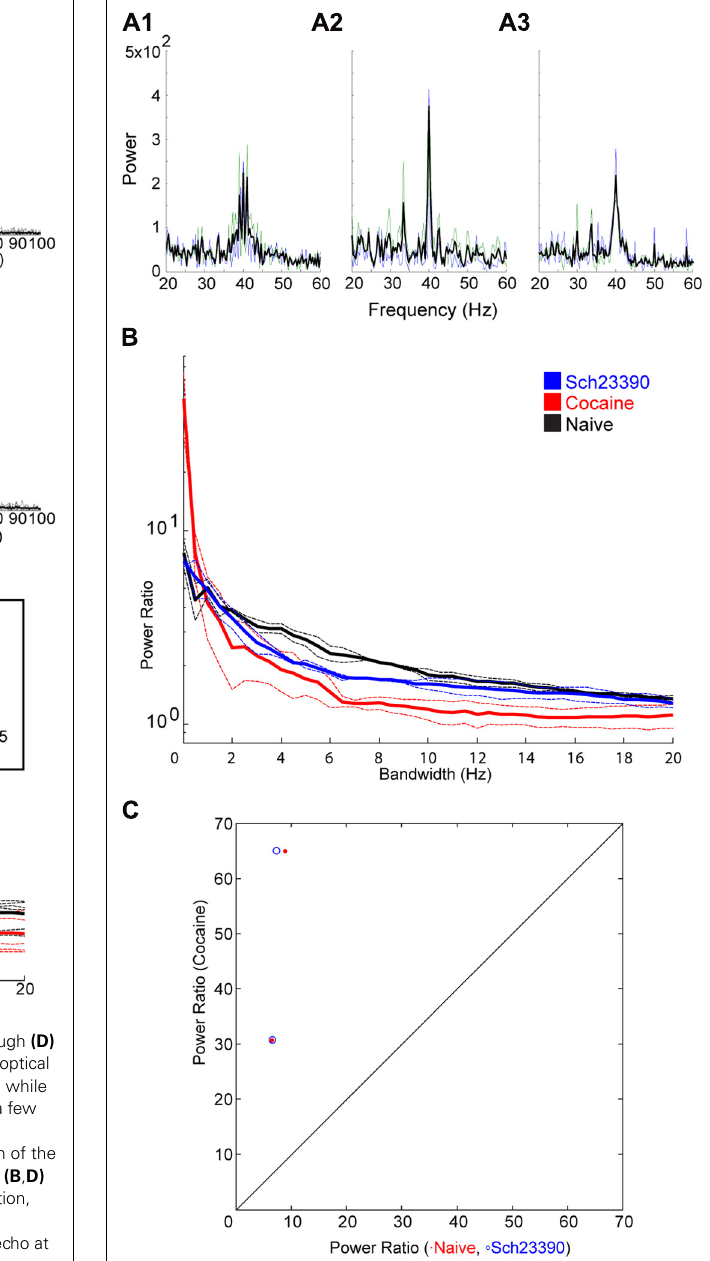
FIGURE 5 | Effect of the D1 antagonist SCH23390 on the cocaine induced change to the induced oscillation. (A) Power spectra around the stimulated frequency in naïve (A1), cocaine (A2), and SCH23390 (A3) conditions. Sharpening of the peak is seen here again and appears to be reversed by SCH23390. (B) Power ratio vs. bandwidth plot reflecting the changes in peak power and bandwidth seen above. SCH23390 appears to block the sharpening effect of cocaine treatment. (C) Comparison of power ratio at the peak, across treatment conditions. Above the line represents a larger power ratio in cocaine treatment vs. either naïve (red) or SCH23390 (blue). Data points are nearly overlapping demonstrating that SCH23390 appears similar to the naïve